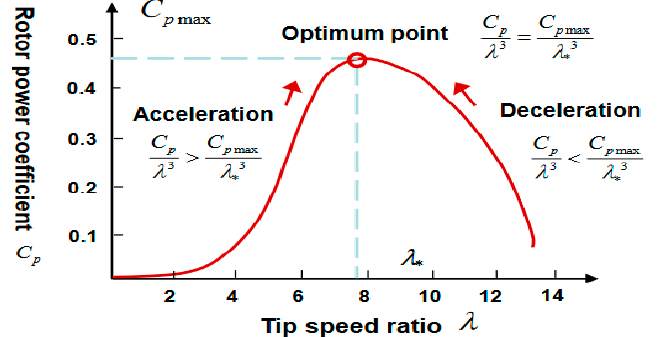
Figure 5. The relation between rotor power coefficient and tip speed ratio.